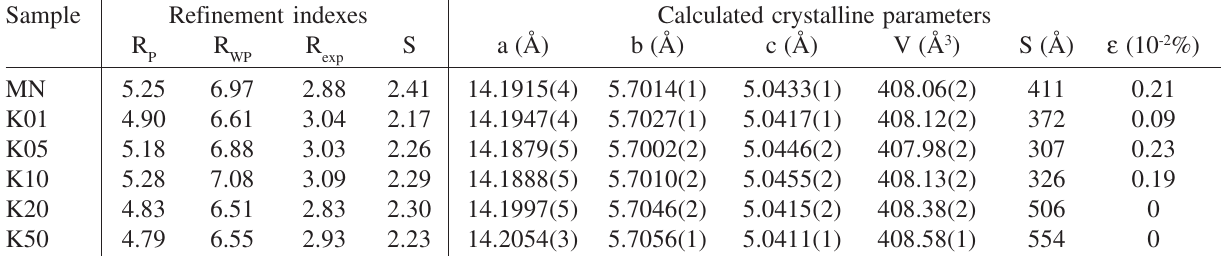
Table 2. Refinement results for K-doped MN